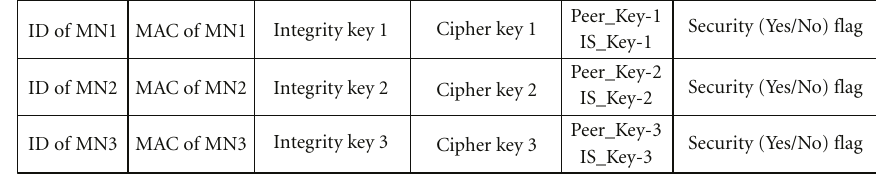
Figure 19: Format of security keys table in AR. Table 3: Result analysis and comparison summary.